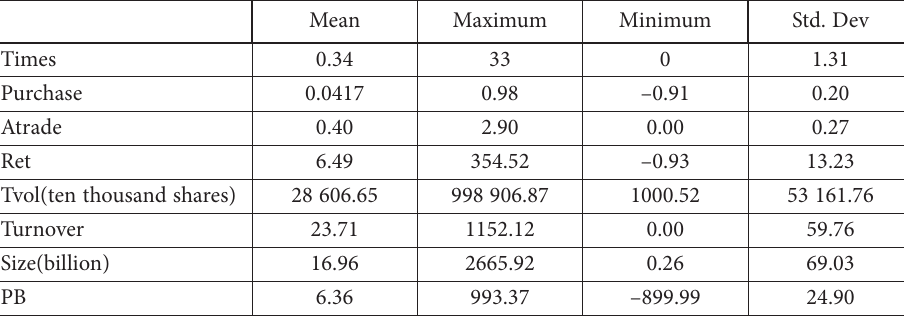
Table 1. Descriptive statistics of the main